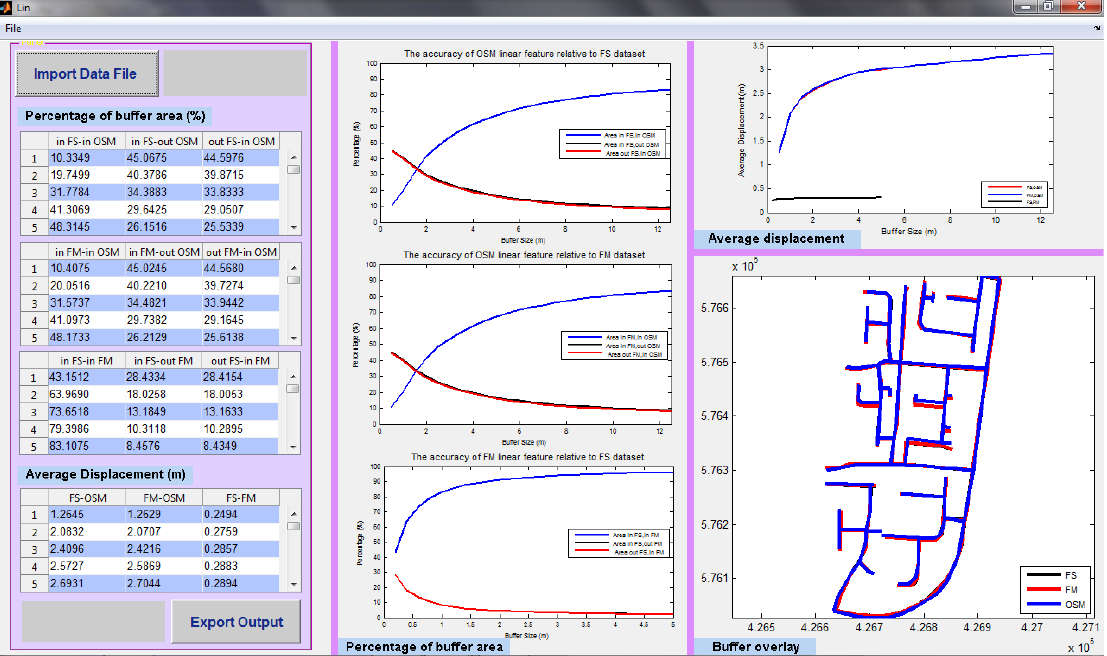
Figure 10. The linear similarity measurement results for the comparison of FS, OS—noted as FM, formal data, and OSM in Cramlington,